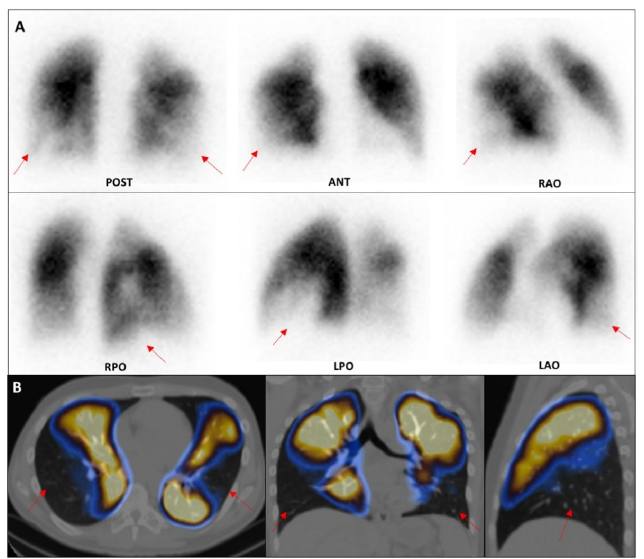
Figure 6. Lung perfusion scintigraphy performed for the suspicion of APE in a 32-year-old patient affected by a genetic rare disease (MTHFR mutation), who presented severe dyspnoea, hypoxia/hypocapnia at arterial blood gas analysis, increased d-dimer values (3253 ug/L, n.v. < 500), and referred allergic diathesis. Planar ( A ) and SPECT/CT ( B ) acquisitions demonstrated multiple wide wedge-shaped segmental perfusion defects in both lower lobes, thus confirming the suspicion of APE. Consequently, the patient was immediately referred to the intensive care unit for prompt therapeutic support. POST: posterior; ANT: anterior; RPO: right posterior oblique; RAO: right anterior oblique; LPO: left posterior oblique; LAO: left anterior oblique.